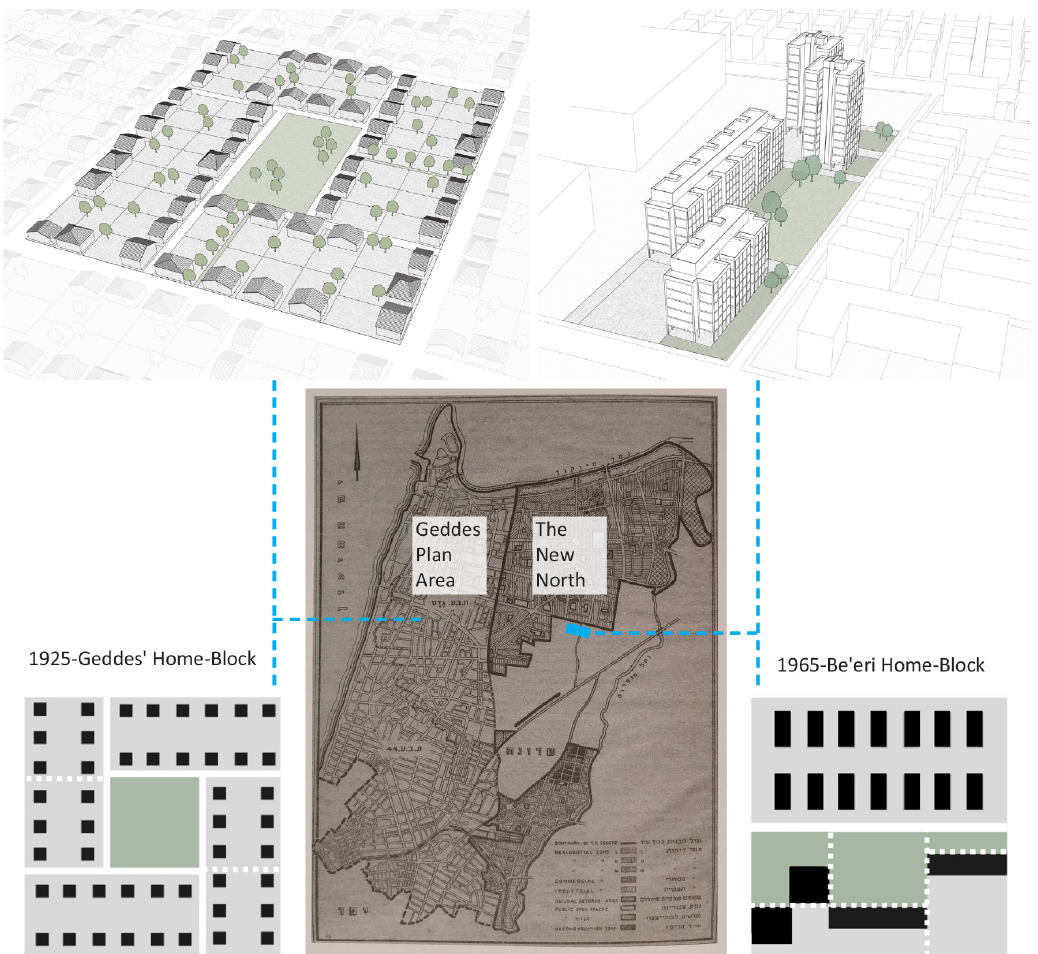
Figure 6. Be’eri estate typological criticism of Tel Aviv’s urban block. functions like a small city, involving various city‐like com‐ mon facilities, shared by all